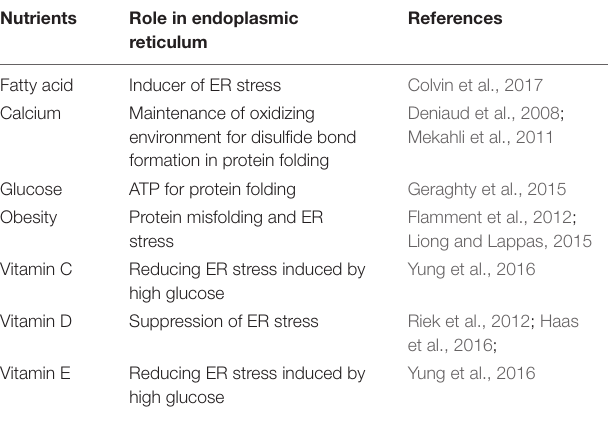
TABLE 3 | Role of nutrients in endoplasmic